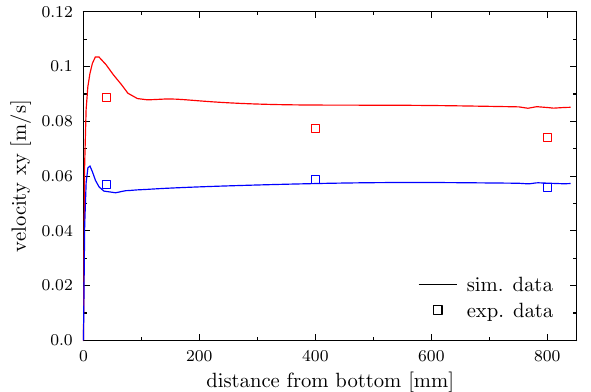
Figure 6. Comparison of the simulation results with experimental data [19] in six positions lying on vertical lines in the tank. The upper curve and experimental points correspond to position angle 271 ◦ and radius 573 mm; the lower curve and points represent position angle 262 ◦ and radius 367 mm. Distance from the bottom of the tank (z coordinate) is on the horizontal axis, and the vertical axis represents velocity magnitude in horizontal (XY) planes because the FlowTracker measurement device provided data in 2-D planes